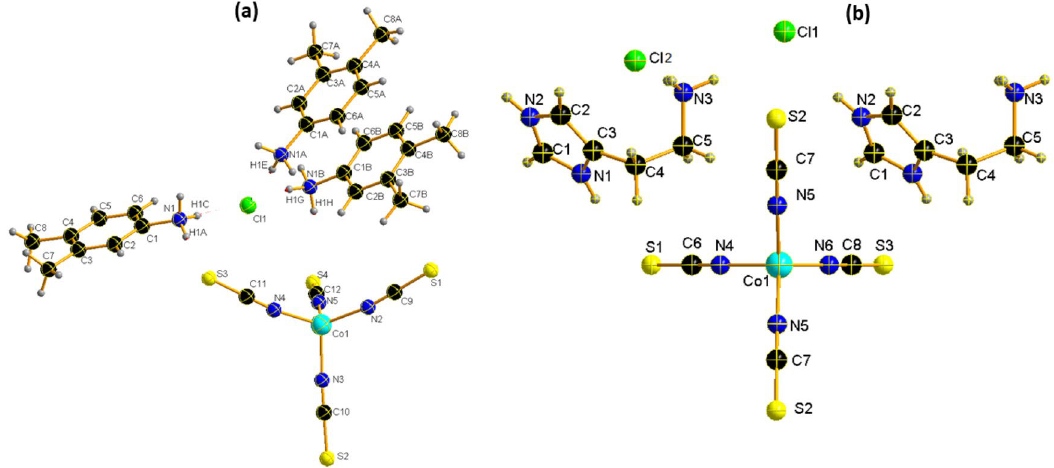
Figure 1. ORTEP Views of ( a ) {[Co(SCN) 4 ] (C 8 H 12 N) 3 }·Cl and ( b ) {[Co(SCN) 4 ] (C 5 H 11 N 3 ) 3